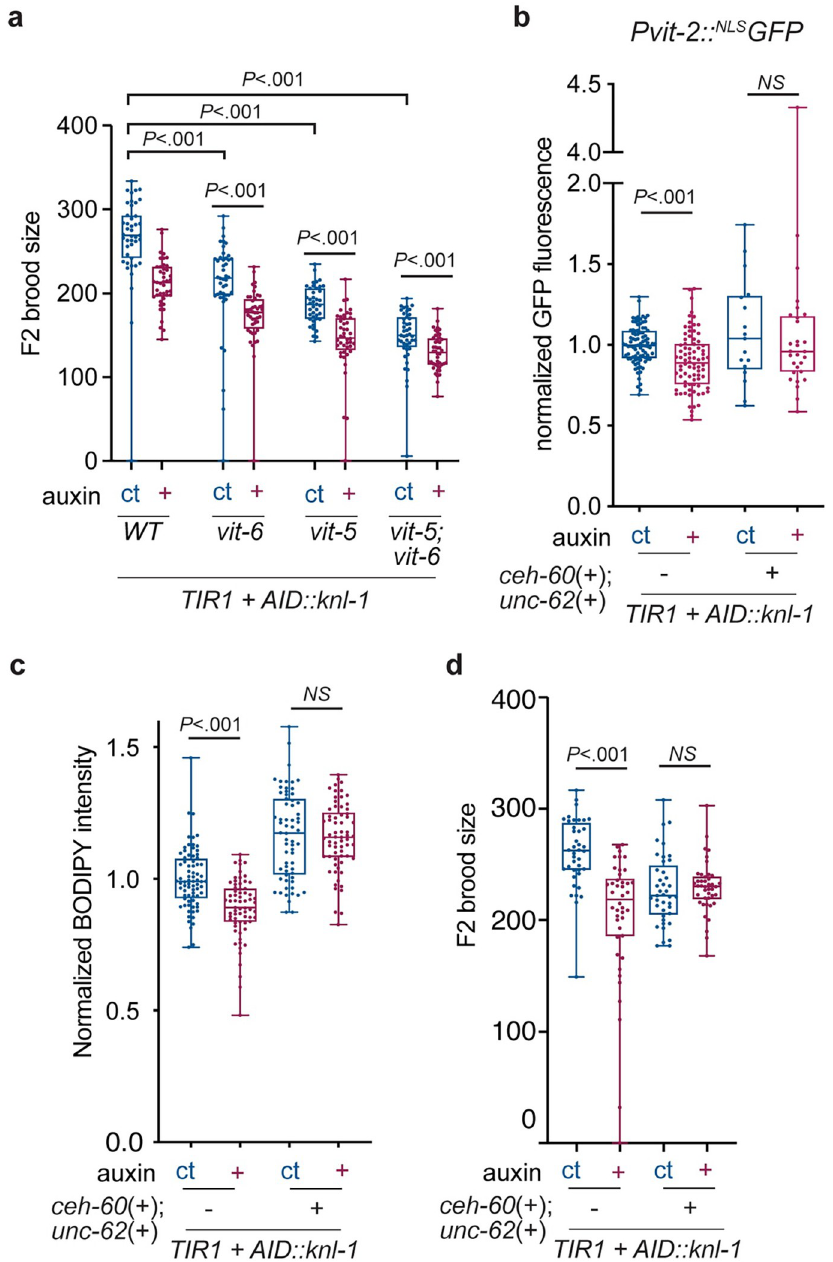
Fig 7. Transient activation of vitellogenin expression rescues defects of animals with mononucleated intestines. (A) F2 brood sizes of Pges-1 :: TIR1; AID :: knl-1 animals containing deletions in either vit-5 , vit-6 , or both. F2 brood sizes were measured from the progeny of animals with either mononucleated (+, n = 43 to 44) or binucleated (ct, n = 41 to 44) intestines that had been laid during the first day of adulthood (maternal age 48–72), in 2 replicate experiments. Animals without vit-5 or vit-6 deletions (wild type) were taken along as controls. (B) Normalized total Pvit-2 :: NLS GFP fluorescence intensity per animal, for animals grown under auxin (+) or control (ct) conditions and with (+, n = 17 and 29) or without ( − , n = 82 and 89) intestinal overexpression of transcription factors ceh-60 and unc-62 , measured at young adulthood in 5 replicate experiments. Scatter plot with line and error bars indicating mean and SEM. (C) Normalized total fluorescence intensities of BODIPY lipid staining of early embryos isolated from young adult (72 hours) Pges-1 :: TIR1; AID :: knl-1 animals with or without intestinal overexpression of CEH-60 and UNC-62, grown under control (ct, n = 76 and 64) or auxin (+, n = 67 and 64) conditions in 3 replicate experiments. Boxplots indicate the median and 25th to 75th percentile, error bars indicate min to max values, and individual values are shown as dots. (D) F2 brood sizes of Pges-1 :: TIR1; AID :: knl-1 animals with or without intestinal overexpression of CEH-60 and